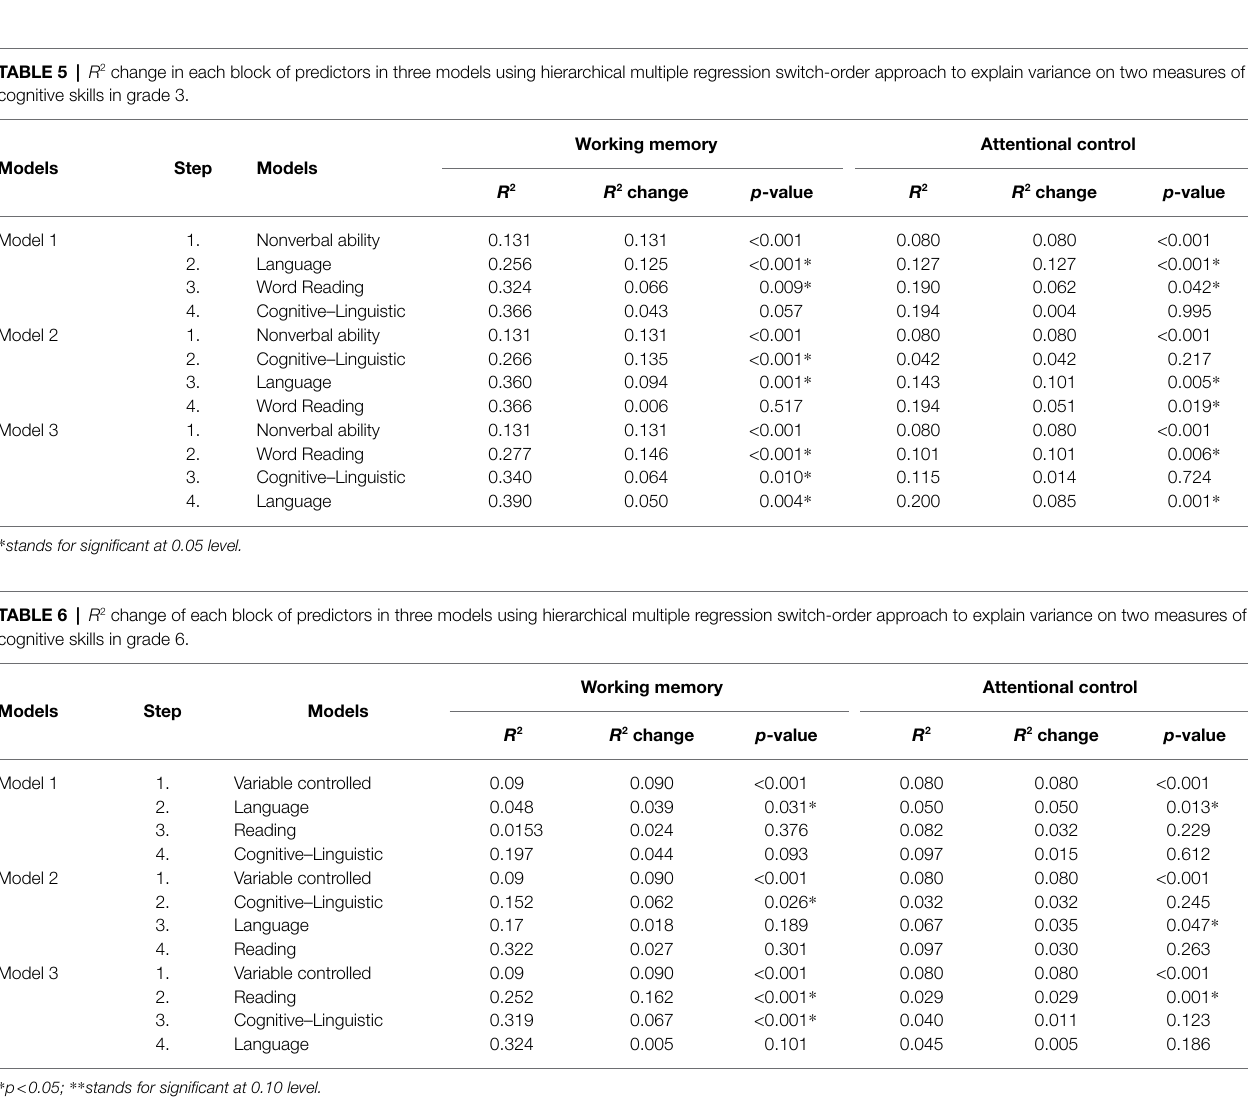
TABLE 5 | R 2 change in each block of predictors in three models using hierarchical multiple regression switch-order approach to explain variance on two measures of cognitive skills in grade 3.